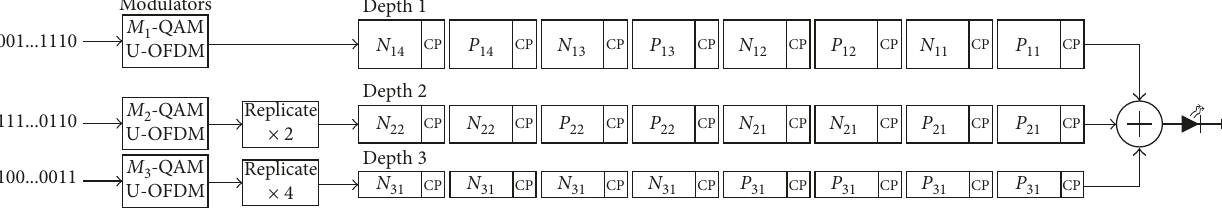
Figure 2: Frame design of